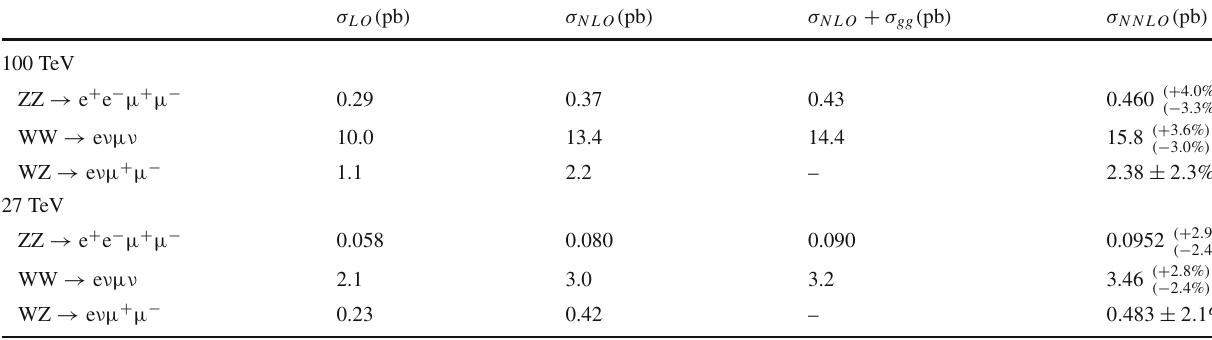
Fig. 3.3 Integrated lepton transverse (dilepton) mass distribution in pp → W ∗ → (cid:13) ν (pp → Z ∗ / γ ∗ → (cid:13) + (cid:13) − ), at 100 and 27 TeV. One lepton family is included, with | η (cid:13) | < 2 . 5 Table 3.3 Gauge boson pair production cross sections. σ gg refers to the total cross sections, obtained by varying renormalisation and factorisa- gg → VV process, which, whileformally of NNLO, appears atthe one- tion scales ( μ R , F ), independently, over μ R , F /μ 0 = 0 . 5 , 12 and 1 / 2 loop level. The NNLO systematics reflects the scale dependence of the